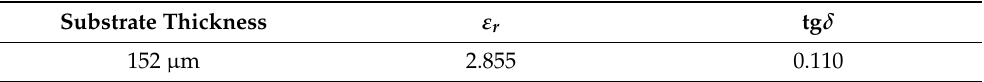
Table 9. Measured dielectric parameters of DuPONT Pyralux LF9150R, at 866 MHz. Substrate